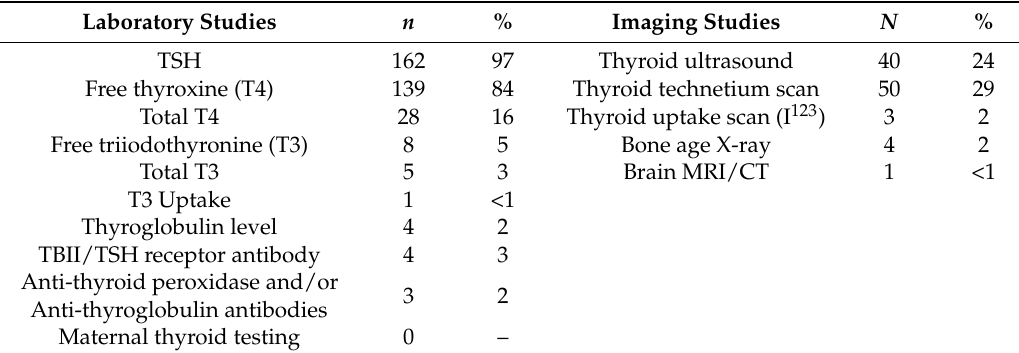
Table 2. Clinicians report of studies used to confirm CH diagnosis *.